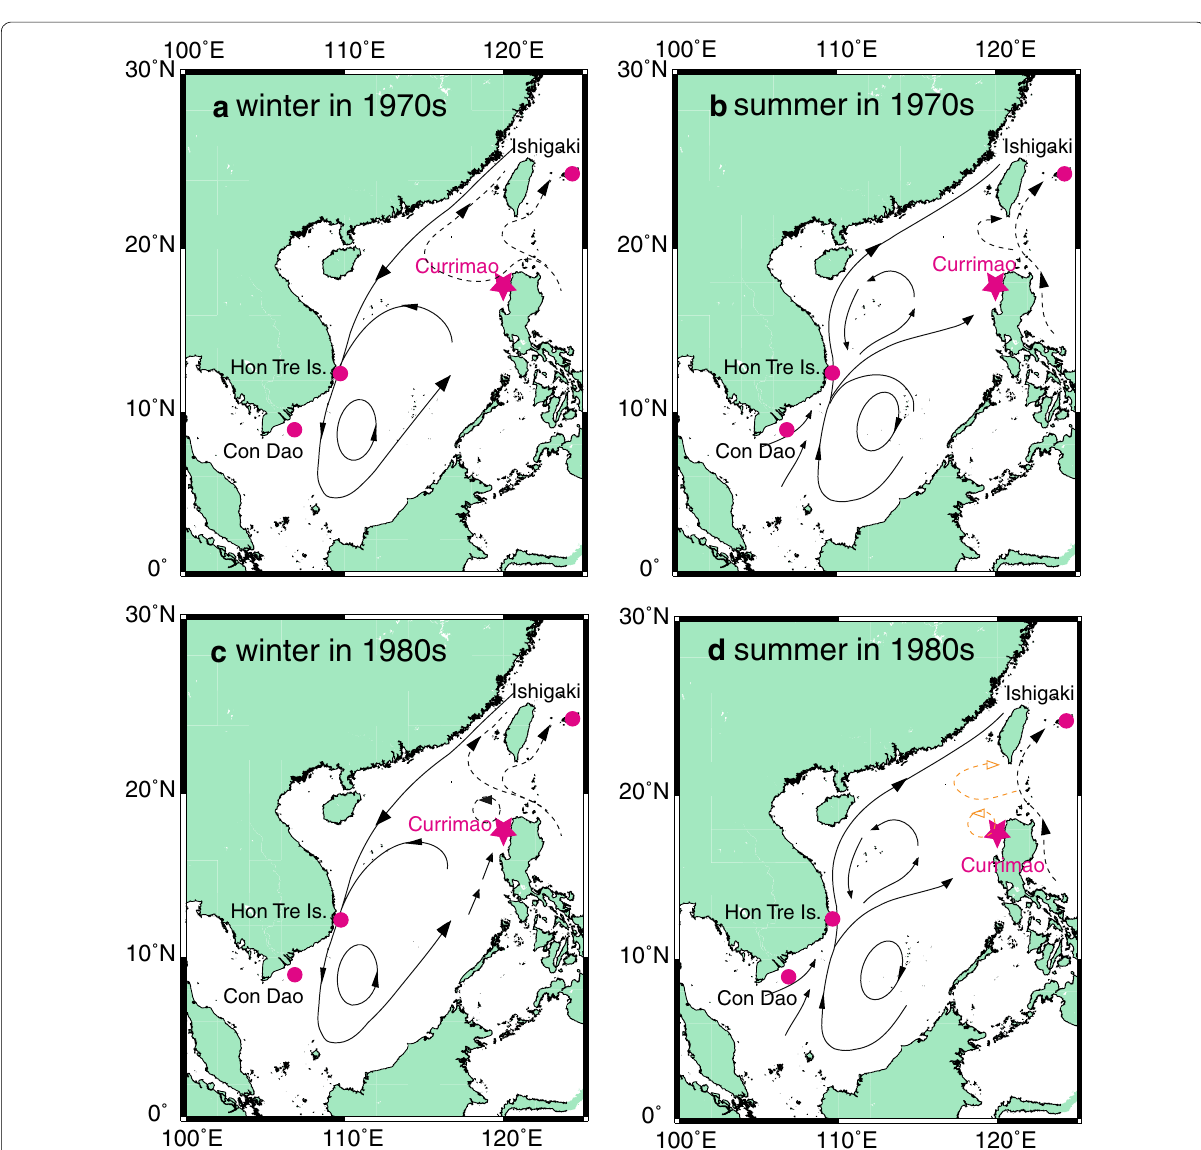
Fig. 5 Schematic illustration of surface ocean circulation in the South China Sea. The main current ( black solid lines ) of the South China Sea is based on Wang and Li (2009). The path of the Kuroshio loop current ( black dotted line ) fluctuated in ( a , b ) the 1970s and ( c , d ) the 1980s. The orange arrows in d are for the periods 1985 and